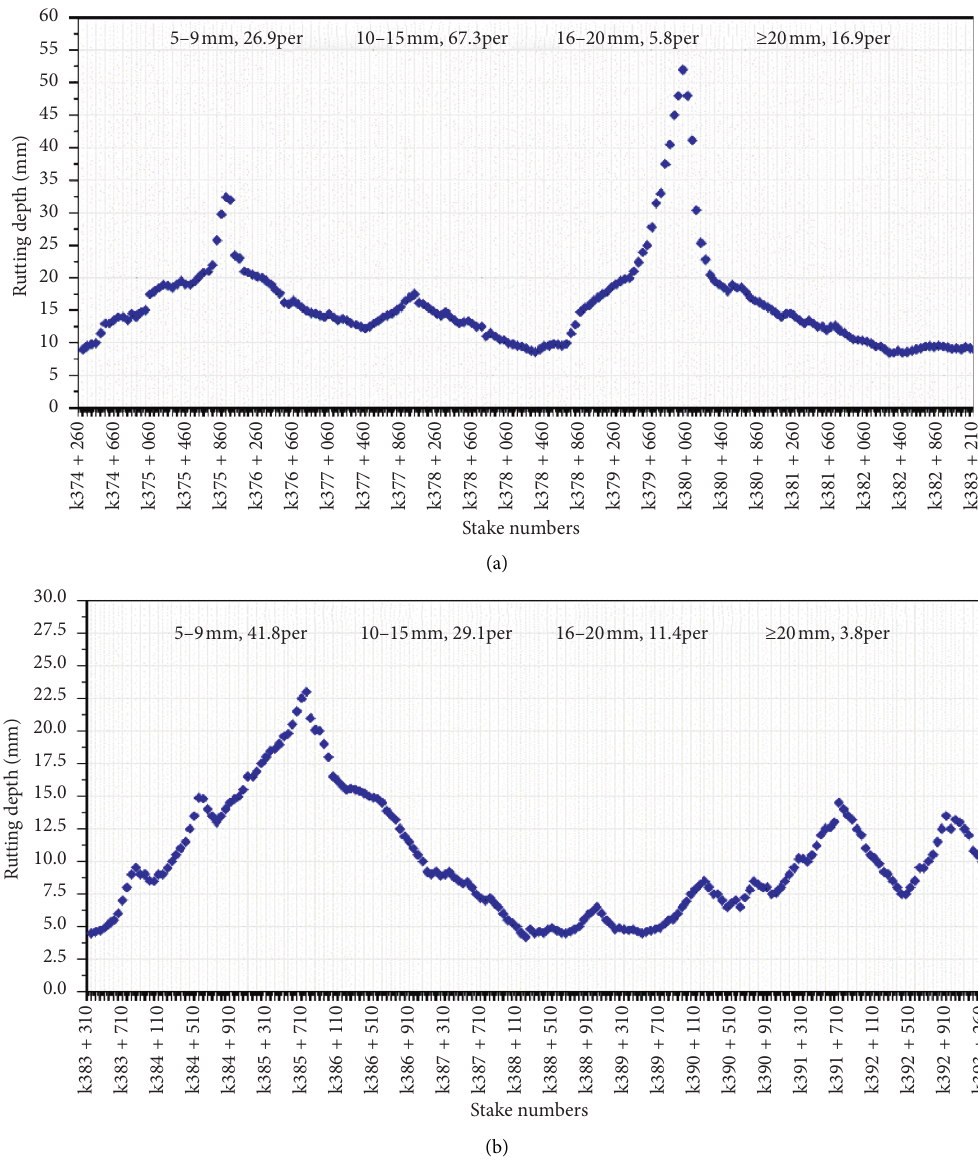
Figure 11: The rutting depth of two sections after three years: (a) Section I. (b) Section II.